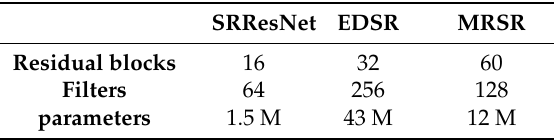
Table 1. Parameters comparison.